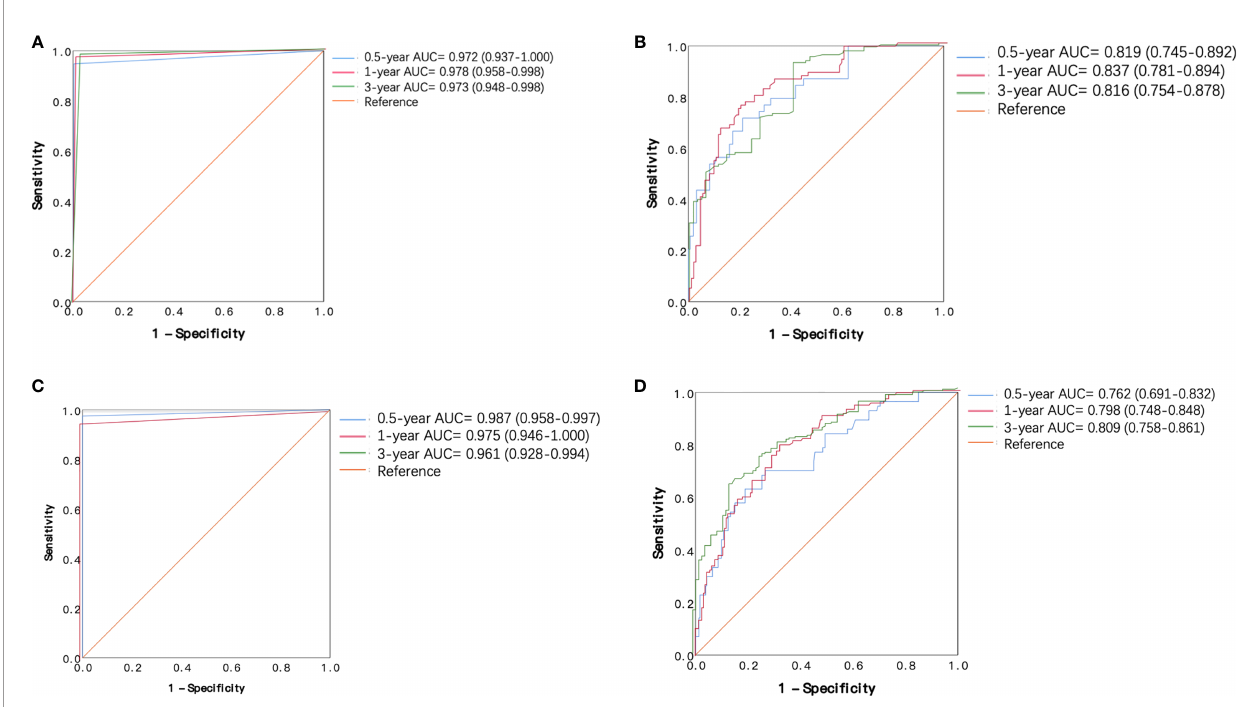
FIGURE 4 | Receiver operating characteristic (ROC) curves of the decision tree model and regression model in the training cohort and validation cohort. (A) ROC curves of decision tree model in the training cohort. (B) ROC curves of regression models in the training cohort. (C) ROC curves of decision tree model in the validation cohort. (D) ROC curves of regression model in the validation cohort.